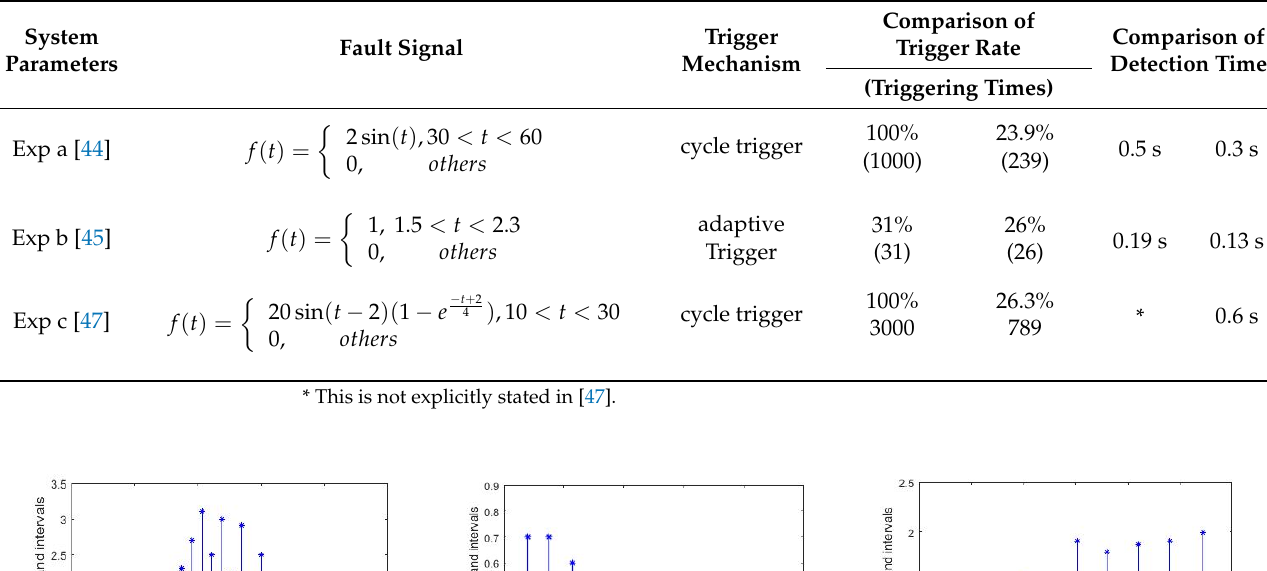
Table 3. Verification for different types of faults.